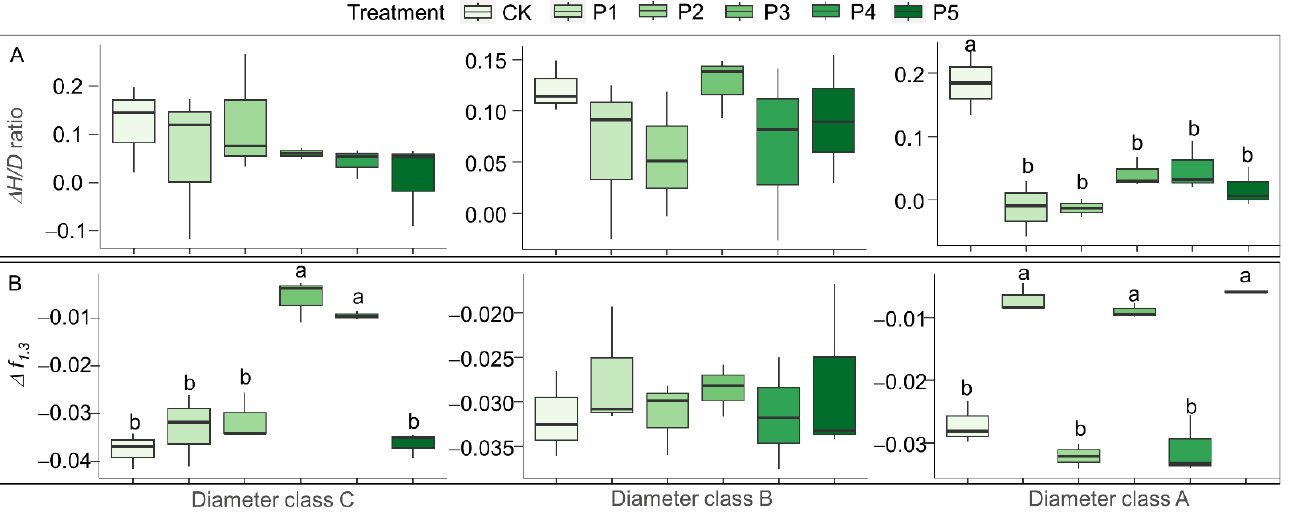
Figure 4. Effects of pruning on height-to-diameter ratio and breast height form factor in P. massoniana plantation. Panels ( A , B ) represent changes in height-to-diameter ratio ( Δ H/D ) and changes in breast height form factor ( Δ f 1.3 ) from March 2019 to December 2021, respectively. Lowercase letters in the fi gure indicate a signi fi cant di ff erence between treatments ( p < 0.05).